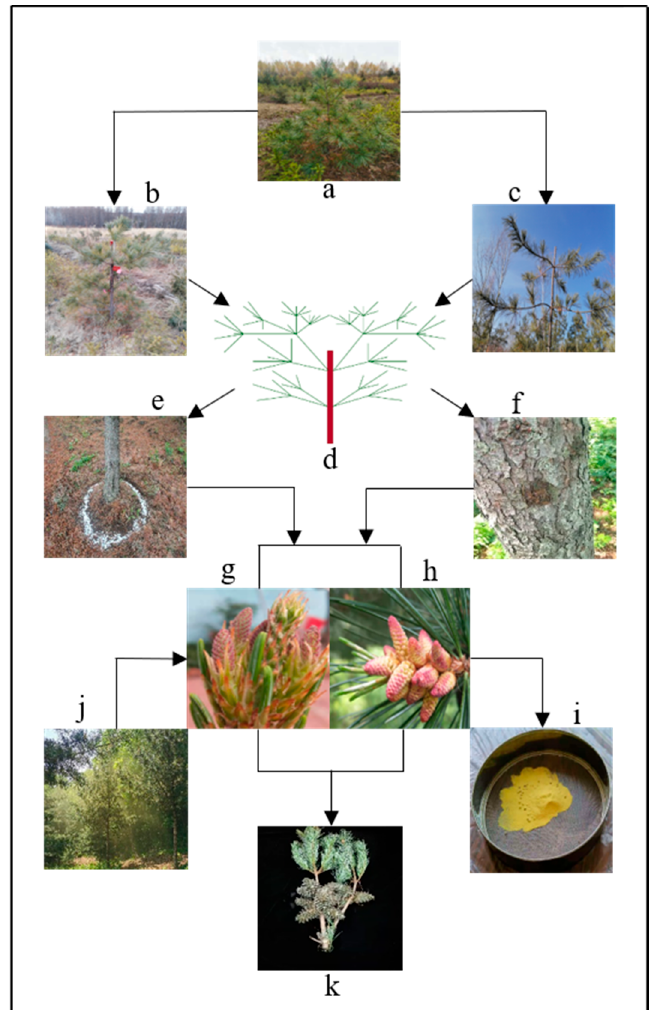
Figure 1. Flowering and seed yields in conifers are affected by a variety of factors (pollen, temperature, light, water availability, nutrients, etc.) and that for improving cone yields a number of management techniques have been tested, including topping off, pruning, fertilization, hormone regulation, supplementary pollination, etc. Panel ( a ) represents the 5–10-year-old tree of conifer species ( P. koraiensis for example), panel ( b ) is topping off, panel ( c ) is pruning, panel ( d ) shows ideal tree shape, panel ( e ) shows fertilization and watering, panel ( f ) depicts hormone application, panels ( g ) and ( h ) are female and male cones, respectively, panel ( i ) shows pollen storage, panel ( j ) depicts supplementary pollination and panel ( k ) shows improved cone yield.